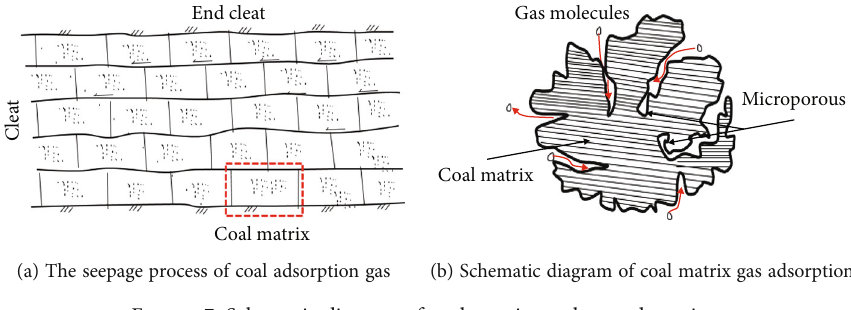
Figure 7: Schematic diagram of coal matrix methane adsorption. Table 3: Porosity and tortuosity parameters of coal